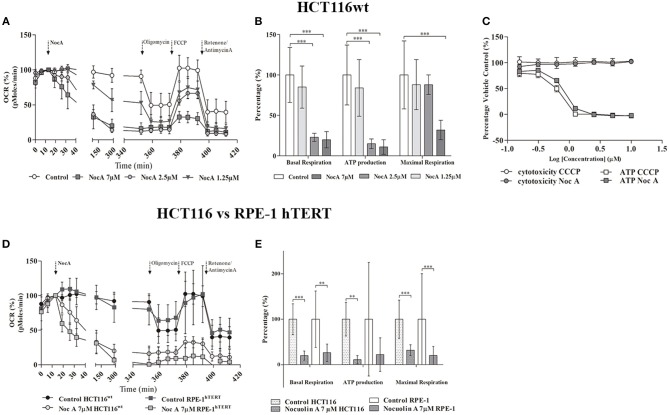
Seahorse analysis of cellular respiration. (A) Oxygen consumption rates by HCT116wt cells over 6 h in response to exposure to NocA at 1.25, 2.5, and 7 μM. (B) Mitochondrial key parameters—Basal respiration, ATP production, Maximal Respiration—calculated after addition of sequential kit reagents (Oligomycin, FCCP, Antimycin A, and Rotenone) from Seahorse XF Cell Mito Stress Test, Kit ***p < 0.001. (C) Dose-response for glucose-free (galactose supplemented) HCT116wt cells treated with NocA and CCCP and respective cell viability after 2 h of exposure (according to Mitochondrial ToxGlo™ Assay kit). 1 = Log (10 μM) to −0.81 = Log (0.16 μM). (D) Comparison of Oxygen consumption rates between HCT116wt and RPE-1 hTERT cells in response to 6 h exposure to NocA at 7 μM. (E) Mitochondrial key parameters—Basal respiration, ATP production, Maximal Respiration- calculated after using Seahorse XF Cell Mito Stress Test Kit on RPE-1 hTERT and HCT116wt exposed to NocA 7 μM for 6 h. ***p < 0.001; **p < 0.01, n > 5, 3 independent assays.